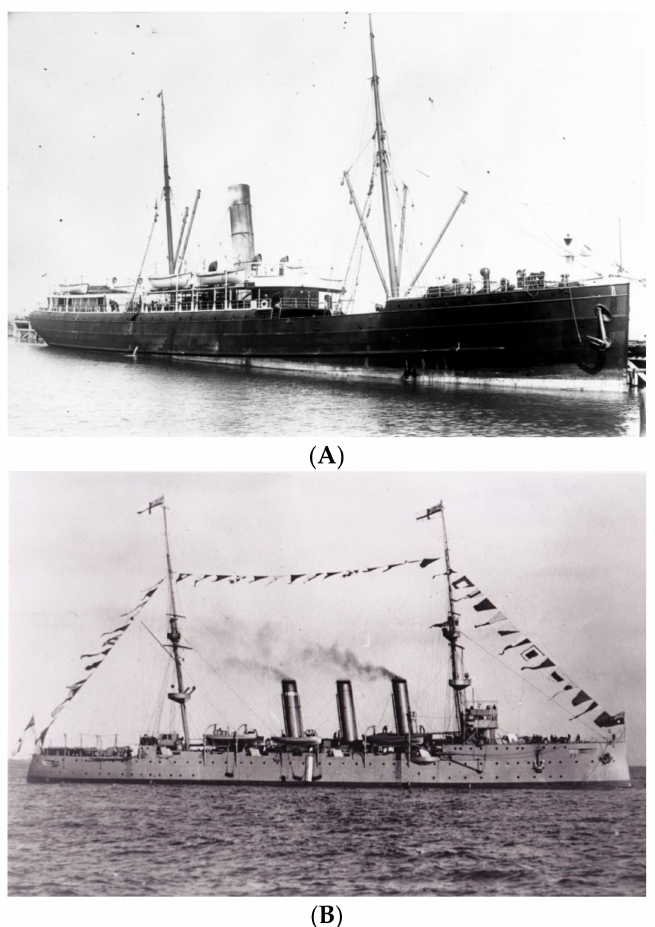
Figure 1. ( A ) The SS Talune shown in Napier, New Zealand in 1908, photo from https://nzhistory.govt. nz/media/photo/influenza-pandemic-hits-samoa, (Ministry for Culture and Heritage), updated 24 October 2014 and ( B ) The Challenger class light cruiser HMAS Encounter shown in Sydney, October 1913. Photo from http://www.navy.gov.au/hmas-encounter-i. News of the end of the First World War arrived just as Samoans began to die of